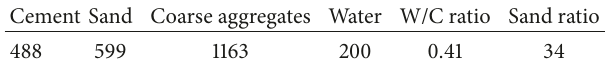
Table 3: OPC concrete mixture composition (kg/m 3